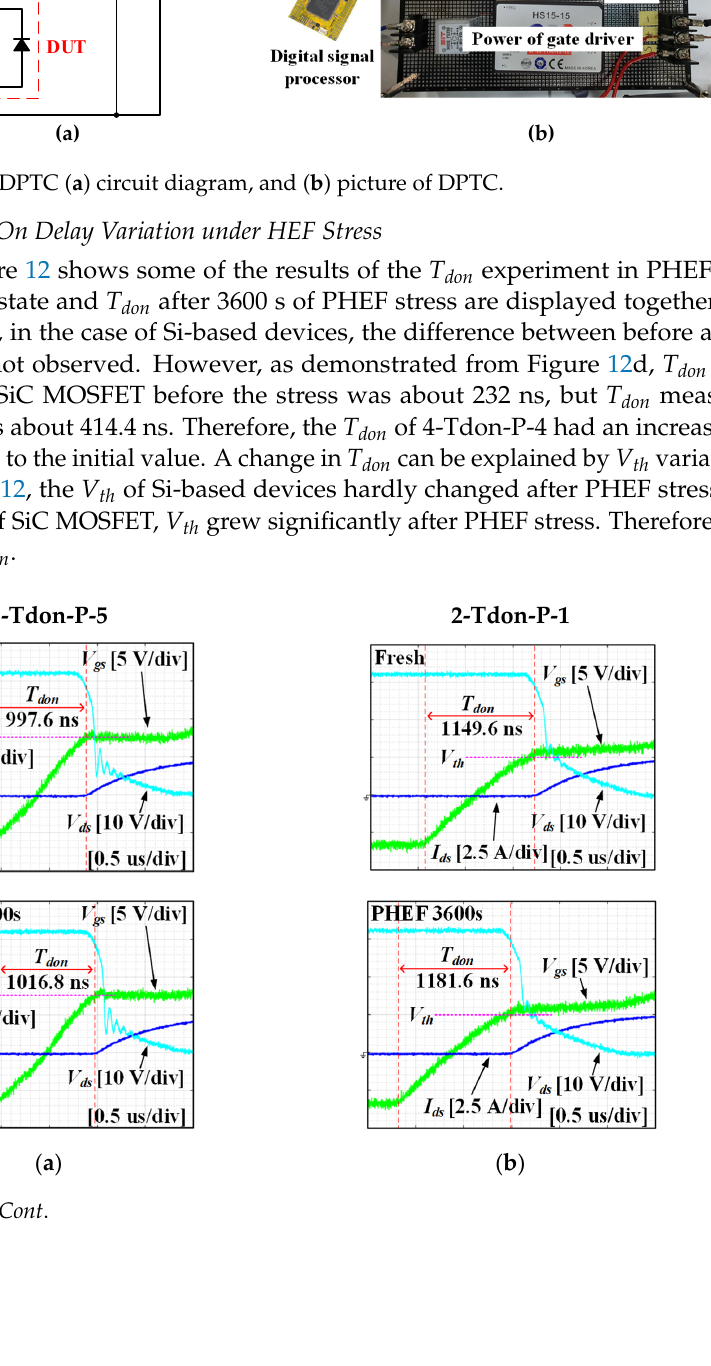
( d ) Figure 12. Turn on waveforms in PHEF stress: ( a ) 1-Tdon-P-1, ( b ) 2-Tdon-P-2, ( c ) 3-Tdon-P-1, and ( d ) 4-Tdon-P-4. Figure 13 shows all of the results of the T don experiment in PHEF stress according to the type of the switching device. Figure 13a–c indicate that there is no significant increase or decrease in T don according to PHEF stress for Si-based devices. However, in the case of SiC MOSFETs, an increasing trend of T don was observed in PHEF stress, similar to V th in Figure 7d. At 900 s of PHEF stress, T don rose sharply and continued to increase. In particu- lar, 4-Tdon-P-4 had a very large variation of about 80% in T don compared to the fresh con- dition after 3600 s of PHEF stress. Other SiC MOSFETs increased by 40% to 50% compared to the initial value. Based on Figures 12 and 13, it can be seen that SiC MOSFETs have a more considerable T don increment during PHEF stress compared to Si-based devices.